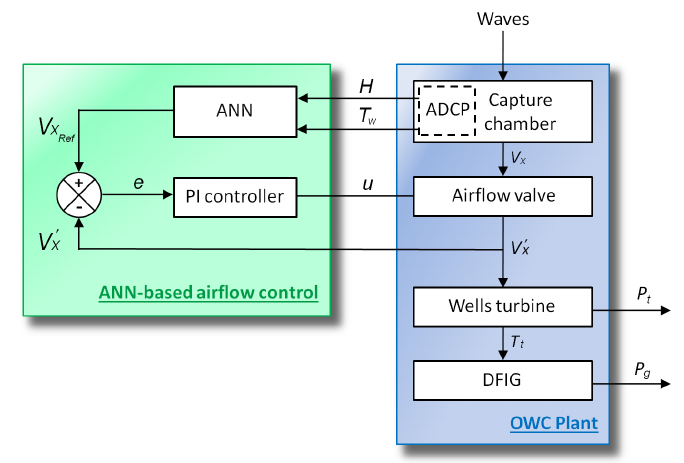
Figure 8. Artificial neural networks (ANN)-based airflow control block diagram for a Wells turbine-based